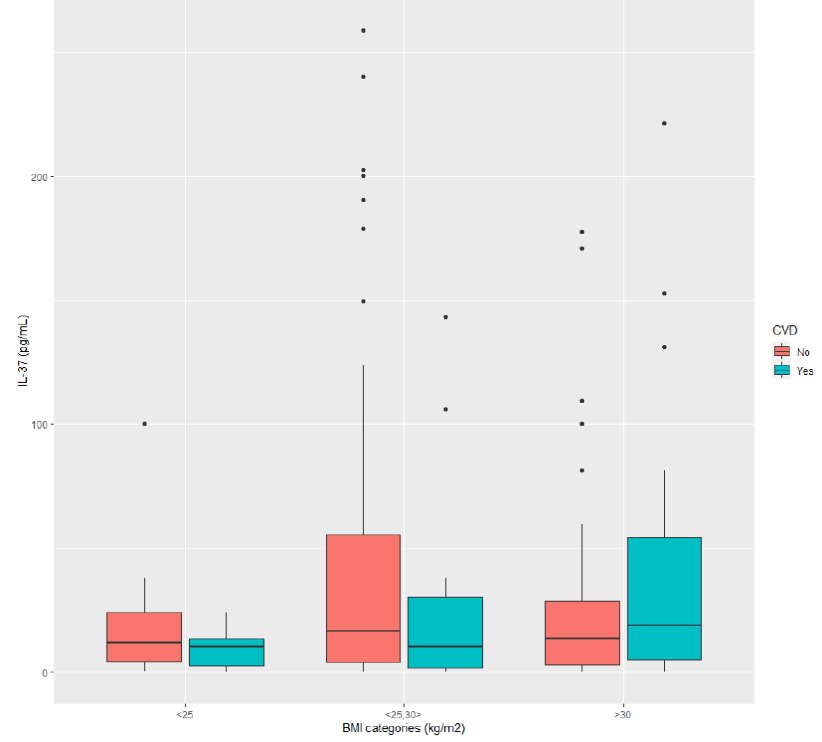
Figure 3. IL-37 in diabetic patients with/without CVD across categories of BMI: low (BMI < 25 kg/m 2 ),